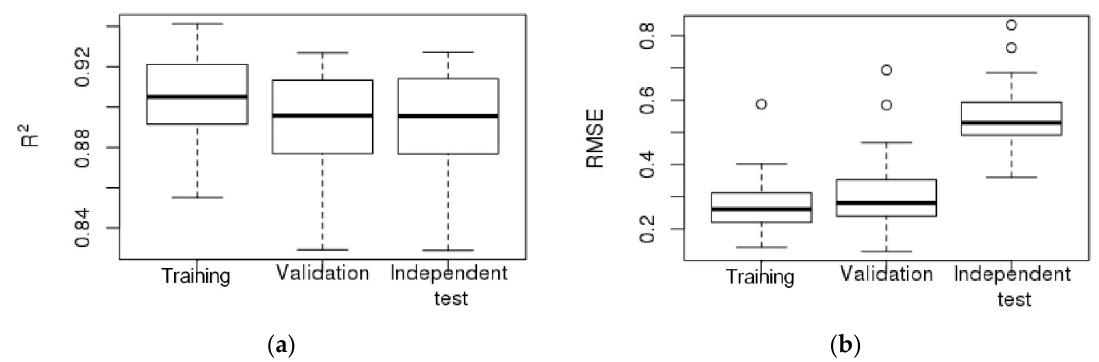
Figure 10. Statistical boxplot for the performance (training, validation and test R 2 ( a ) and RMSE ( b )) of the deep residual network in downscaling using meteorological reanalysis data.